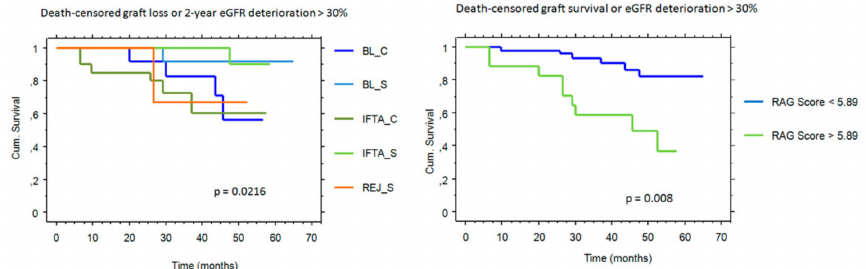
Figure 5. Death-censored graft loss or 2-year eGFR deterioration ≥ 30 % from the date of biopsy in the di ff erent histological categories (left panel) and in biopsies with a positive or negative rejection-associated gene (RAG) score (right panel). REJ-S rejection in surveillance biopsies; BL-C, borderline changes in biopsies for cause; BL-S, borderline changes in surveillance biopsies; IFTA-C, interstitial fibrosis and tubular atrophy in biopsies for cause; IFTA-S, interstitial fibrosis and tubular atrophy in surveillance